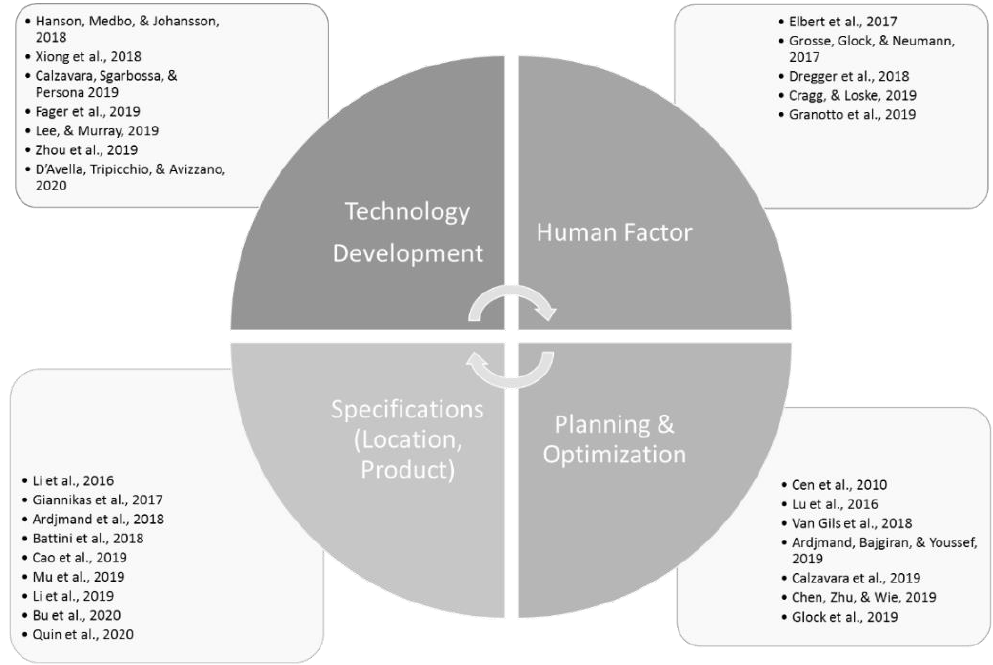
Figure 1. Theoretical framework for efficient order picking.